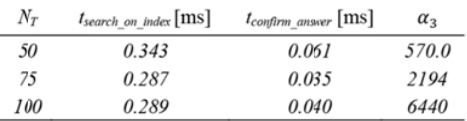
The nu minimum v